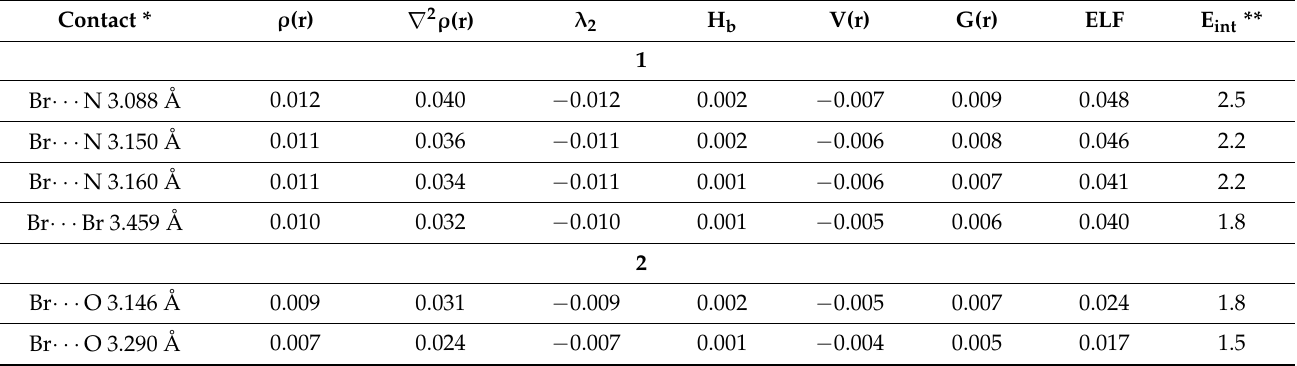
Table 1. Values of the density of all electrons— ρ ( r ), Laplacian of electron density— ∇ 2 ρ ( r ) and appropriate λ 2 eigenvalues, energy density—H b , potential energy density—V( r ), Lagrangian kinetic energy—G( r ), and electron localization function—ELF (a.u.) at the bond critical points (3, − 1), corresponding to halogen bonds Br · · · N, Br · · · Br and Br · · · O in 1 and 2 , and estimated strength for these interactions E int (kcal/mol).